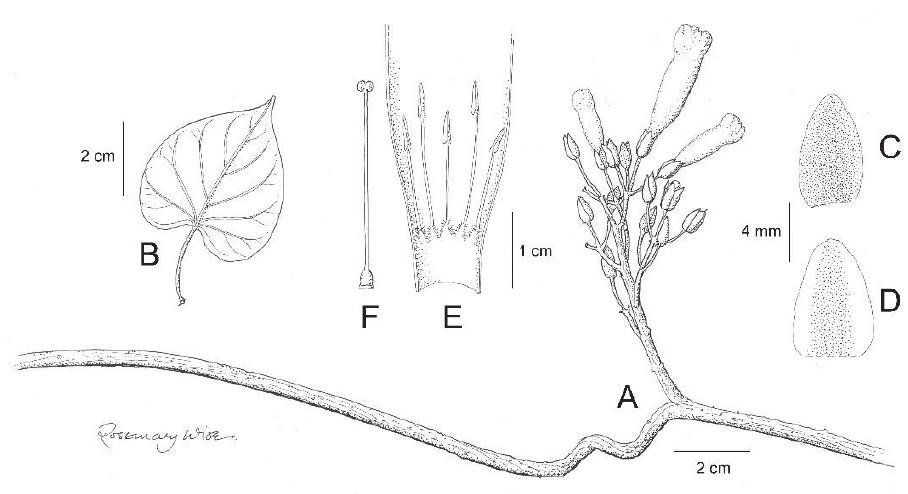
Figure 15. Ipomoea scopulina . A habit B leaf C outer sepal D inner sepal e corolla opened out to show stamens F ovary and style. Drawn by Rosemary Wise from D.P. Saraiva et al.